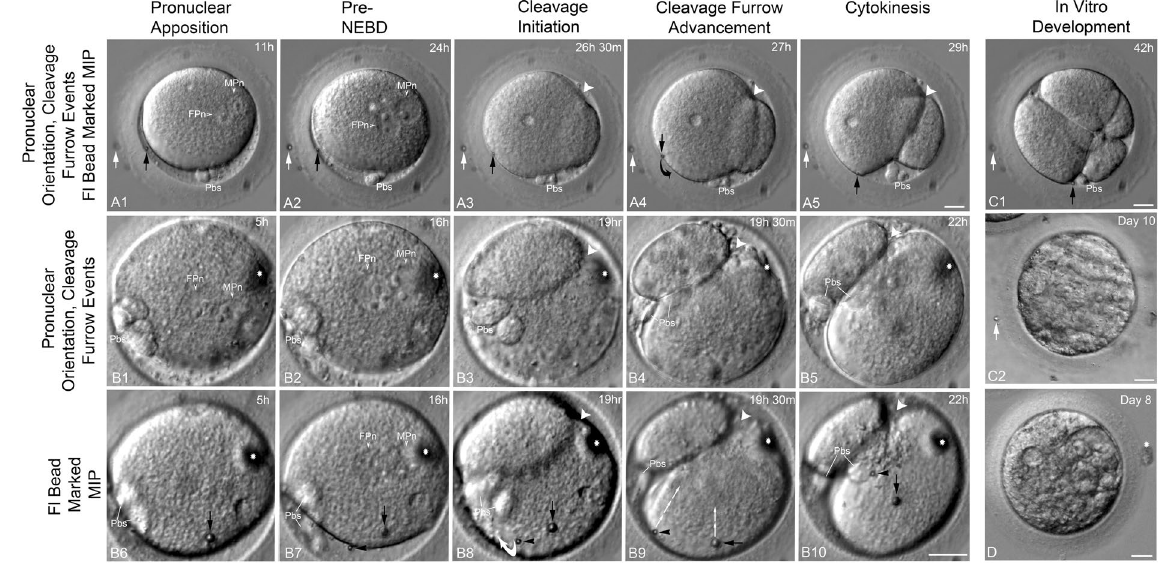
Figure 4. Neither cleavage furrow initiation nor progression includes passage through the sperm microinjection point (MIP). ( A1 – A5 ) A Baboon zygote with radially aligned apposed pronuclei oriented obliquely to the A → V zygotic axis. A detached 3-micron bead within the perivitelline space marks the MIP ( A1 , black arrow). Before mitosis, the expanding cytoplasm re-engages the bead ( A2 , black arrow). An asymmetric cleavage furrow forms near the previously intact apposed pronuclei ( A3 , large arrowhead), progressing meridionally through the polar bodies (Pbs), but not the MIP ( A3 , black arrow). The attached bead rotates by surface membrane flow toward the furrow ( A3 – A4 , black arrows). Post-cytokinesis, the embryo shows unequal cleavage, with polar bodies in the division plane and the bead near the furrow ( A5 , black arrow). ( B1 – B10 ). A Baboon zygote showing pronuclear events ( B1 – B5 ) and movement of two attached marking beads during cytokinesis ( B6–B10 ). A 5-micron bead marks the MIP ( B6 , black arrow); the 3-micron bead marks a distal cortex site ( B7 , black arrowhead). Radially aligned apposed pronuclei are oblique to the A → V axis ( B1 ) with a bead-marked MIP ( B6 : black arrow). The apposed pronuclei translocate cortically, aligning with the A → V axis pre-mitosis ( B2 ). Slight membrane flow exposes both attached beads ( B7 , black arrow, arrowhead). Furrow initiation occurs near the formerly intact MPn ( B3 , white arrowhead), proceeding meridionally toward the polar bodies (Pbs), but not through the beads ( B8 , black arrow, arrowhead). Beads show independent movement; the 3-micron bead initially toward the polar bodies ( B8 , white curved arrow) before redirecting toward the furrow, while the 5-micron MIP bead moves vertically toward the mid-furrow ( B9 , small white arrows). Cytokinesis is unequal, with polar bodies (Pbs) between blastomeres and both beads near the furrow ( B10 , black arrow, arrowhead). ( C1 – C2 ). The A1 – A5 Baboon zygote after in vitro development. Second division is equatorial in both daughter cells, with the MIP bead near the polar body between blastomeres ( C1 ; black arrow). ( D ) The B1 – B10 baboon blastocyst on Day 8 post- in vitro culture. All panels are HMC images. Time